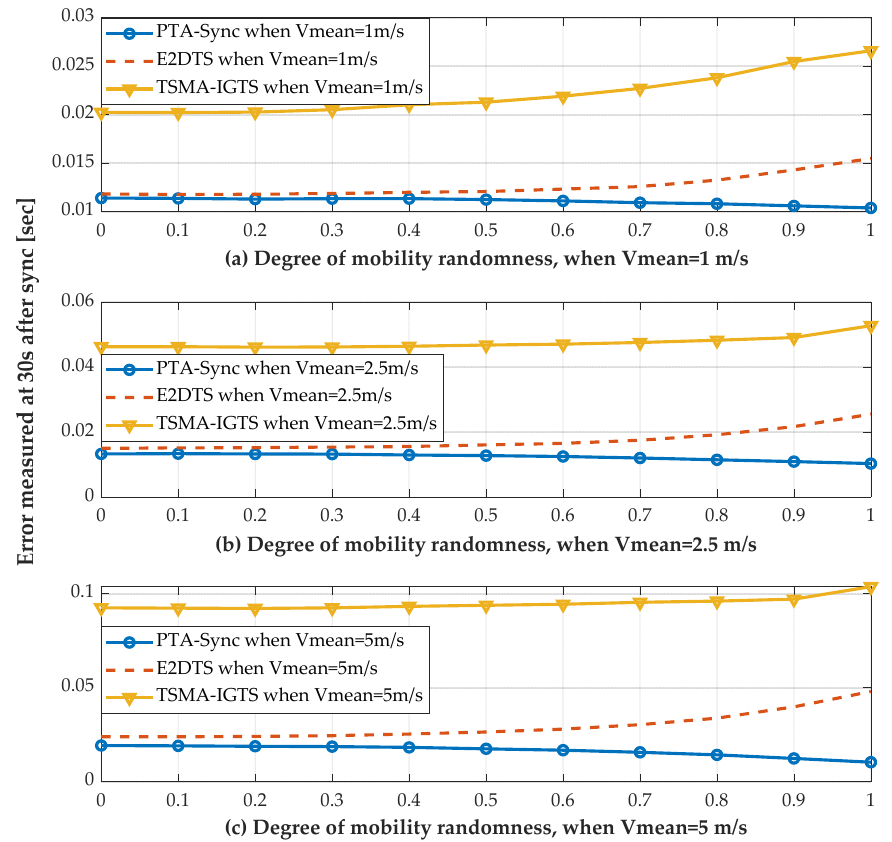
Figure 7. Time error measured at 30 s after synchronization versus α when N_ex = 10, I_tx = 1.2 s, Nr = 15 km, T = 30 s.